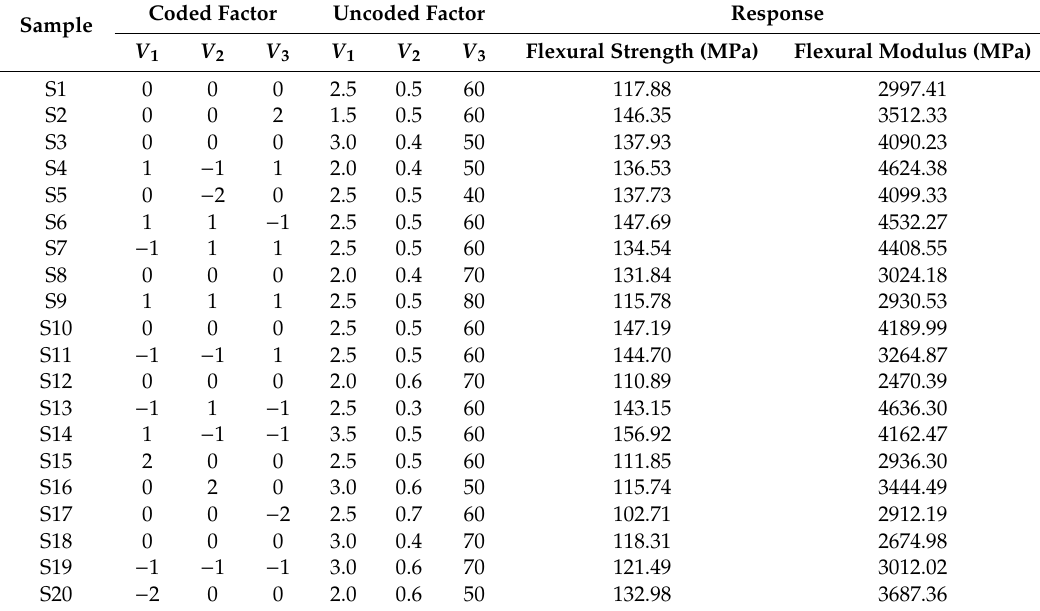
Table 6. Design matrix and response value for the flexural test.